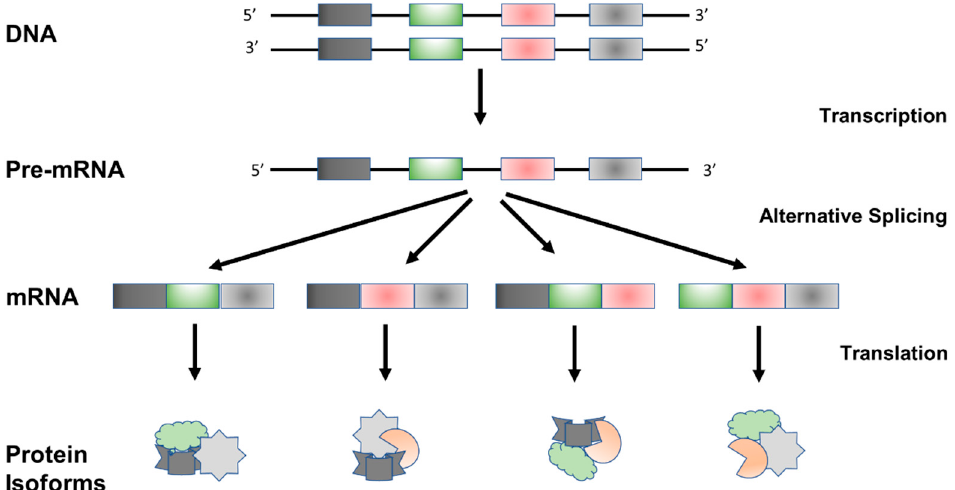
Figure 1. Schematic Representation of Alternative Splicing Process. Alternative splicing leads to functional diversity of transcriptome and proteome by creating a diverse array of protein isoforms from a single gene. Different colors represent difirrent exons and corresponding changes in protein isoforms due to altentaive splicing.